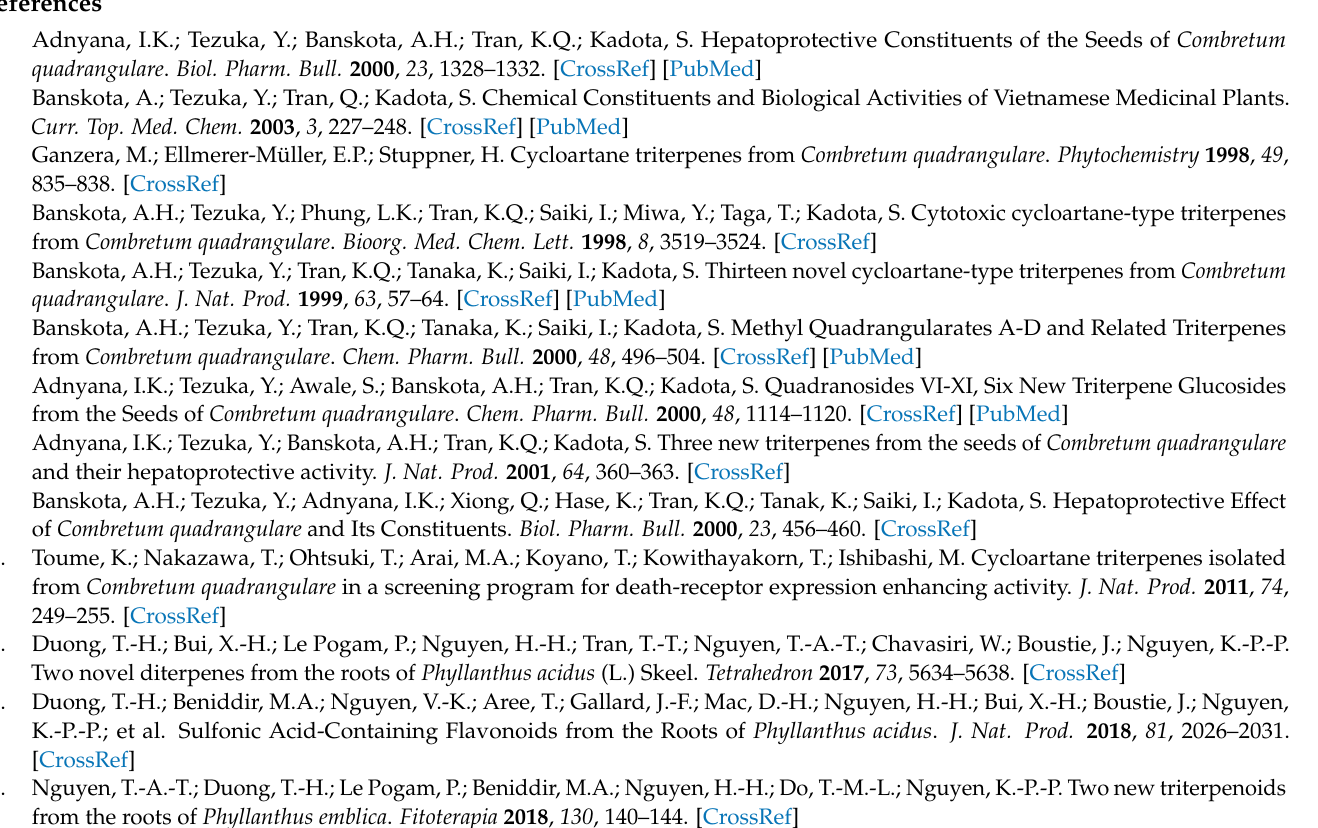
silico molecular docking model of conformation ligands, docking poses, Table S6. Alpha-glucosidase inhibitory activity of fractions, Figure S1. Isolation scheme of compounds from Combretum